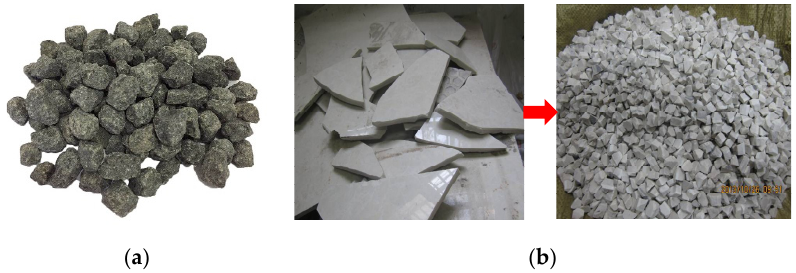
Figure 2. Aggregate used in this study: ( a ) Basalt aggregate; ( b ) Crushed ceramic waste